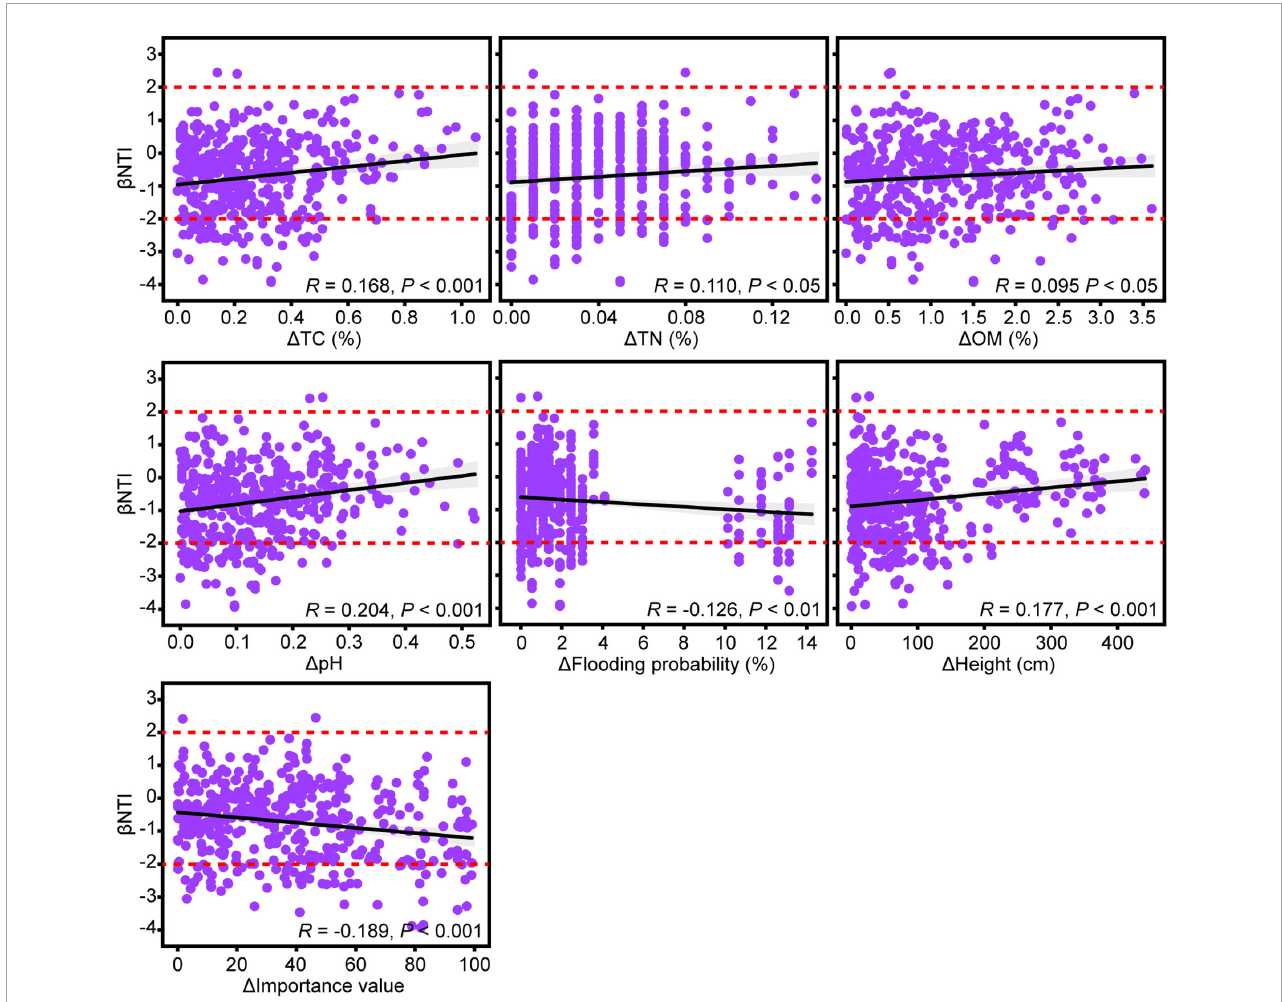
FIGURE4 Linear regressions between β NTI of rhizosphere fungal community and changes in soil environmental factors and aboveground plant traits. Only significant relationships are exhibited based on analysis of variance (ANOVA) at 0.05 level of significance. R values represent Pearson correlation coefficients. Dotted lines indicate the β NTI significance thresholds of –2 and